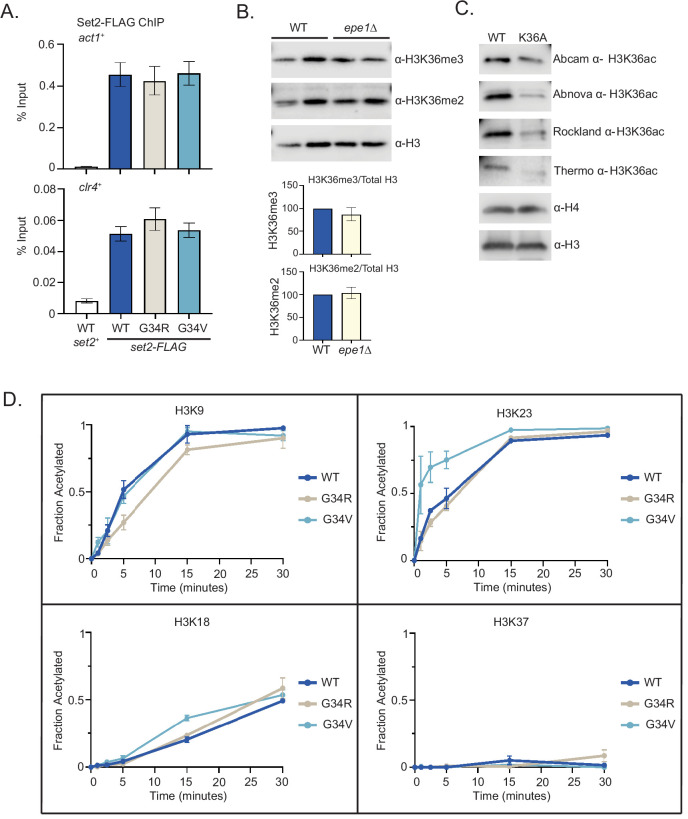
Differential modification of H3K36 in H3-G34R and H3-G34V mutants.(A) ChIP analysis of Set2-3xFLAG expressed from its endogenous locus in H3-WT, H3-G34V, and H3-G34R cells. Set2-FLAG association with act1+ and clr4+ loci is represented as % of input DNA. Data represent mean ± SEM from six biological replicates. No significant difference was found between WT and mutant H3 strains. (B) Western blot analysis of H3K36me3, H3K36me2, and total H3 in WT and epe1Δ cells using chromatin extracts. (lower) Quantification of K36 methylation levels relative to total H3. (C) Western blot analysis of specificity of H3K36ac antibodies using WT and H3-K36A chromatin extracts (Abcam ab177179, Abnova PAB31320, Rockland Immunochemicals 600–401-I89, and Thermo Fischer MA5-24672). Total H4 and H3 were used as loading controls. (D) In vitro histone acetylation assay using recombinant Gcn5 and recombinant WT, G34R, or G34V H3, monitoring H3K9, H3K18, H3K23, and H3K37 acetylation. Data for each time point represents the mean ± SEM from three biological replicates. K27ac was highly variable and was dropped from analysis. (E) Sequence flanking fission yeast H3K36 aligned with known and structurally analyzed GCN5 substrates H3K14 and H4K8. The sites of Gcn5 acetylation are shown in red, while regions making protein contacts with GCN5 in previously characterized structures are denoted in purple. Aqua denotes residues conserved among known substrates. Alignment modified from Poux and Marmorstein, 2003.